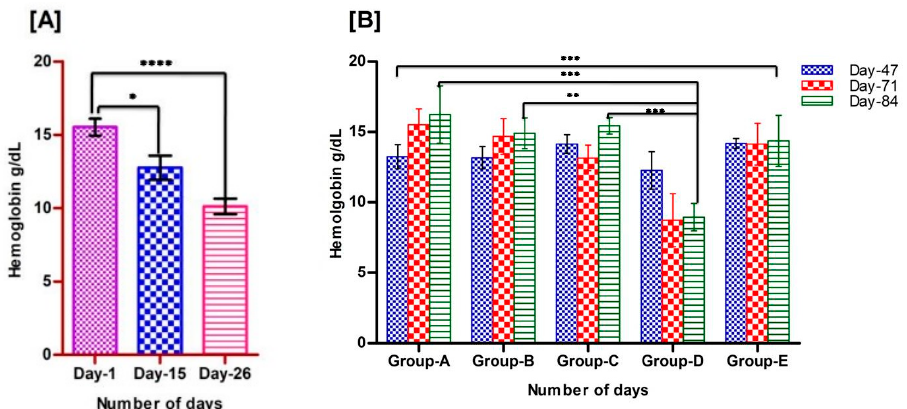
Figure 1. Status of Hb levels in rats, ( A ): Levels of Hb in rats during the development of anemia. Decreased level of Hb was observed on day 26 after feeding an iron-deficient diet, data are presented as mean ± SD, and a two-tailed t-test was performed to see a significant difference; ( B ): Levels of Hb in rats during the regeneration of Hb by feeding diets with fortified salt formulations on day 47, 71, and 84. One-way ANOVA was performed within the groups (Groups A–E) and between the groups (A vs. D, B vs. D, and C vs. D) using GraphPad Prism, and significant results were observed on the recovery of anemia on day 84 (star represents the significance levels; p < 0.0001 ****, p < 0.001 ***, p < 0.01 **, p < 0.05 *).